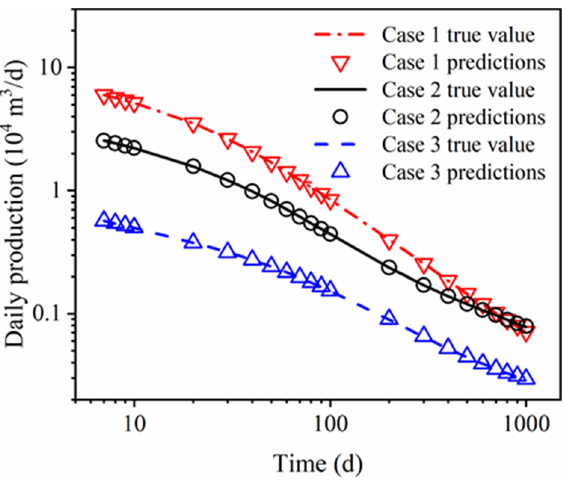
Figure 5. Comparison of the values predicted by the LSTM networks and the true values of the daily shale gas production under three constraint conditions.